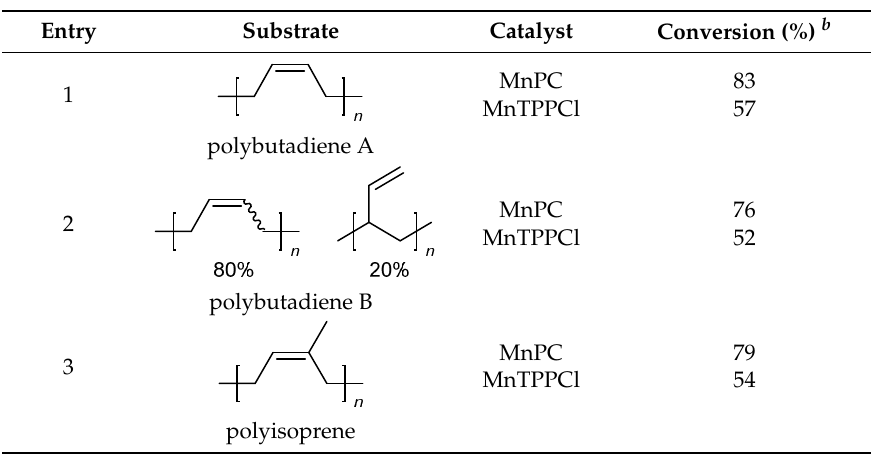
Table 3. Aerobic epoxidation of polymers catalyzed by manganese porphyrin cage catalyst MnPC and reference catalyst MnTPP in the presence of isobutyraldehyde. a